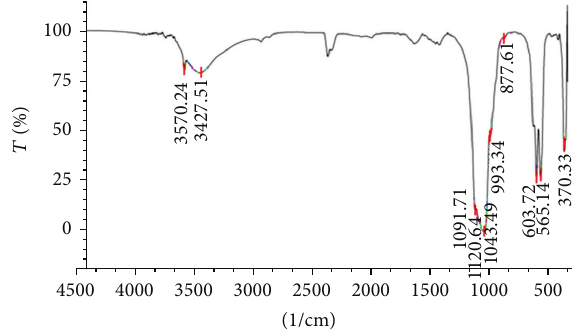
Figure 8: FT-IR spectra of hydroxyapatite (HA) were sintered at 800 ∘ C.